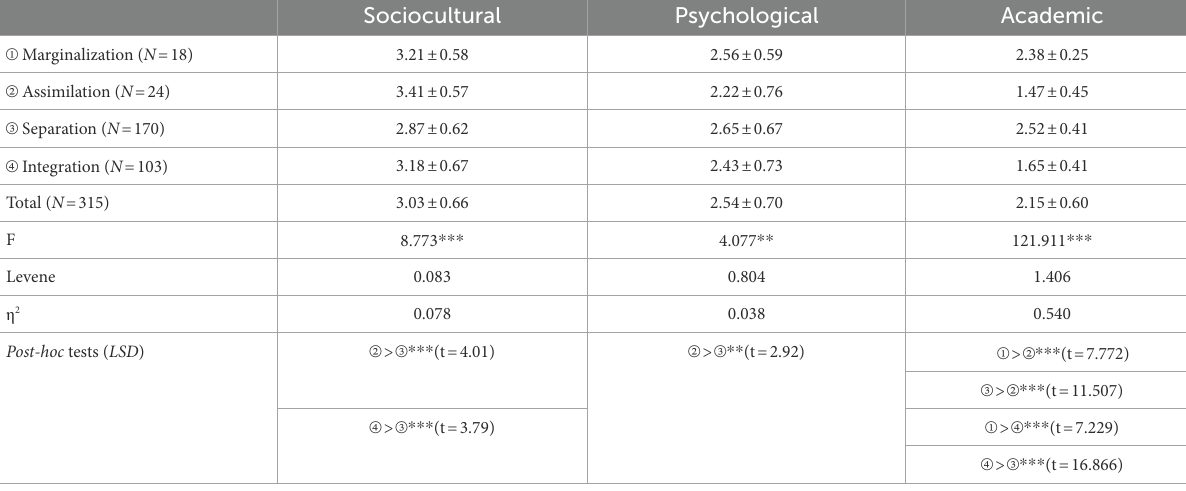
TABLE 5 Comparison of adaptations by different acculturation strategies preference [M ±